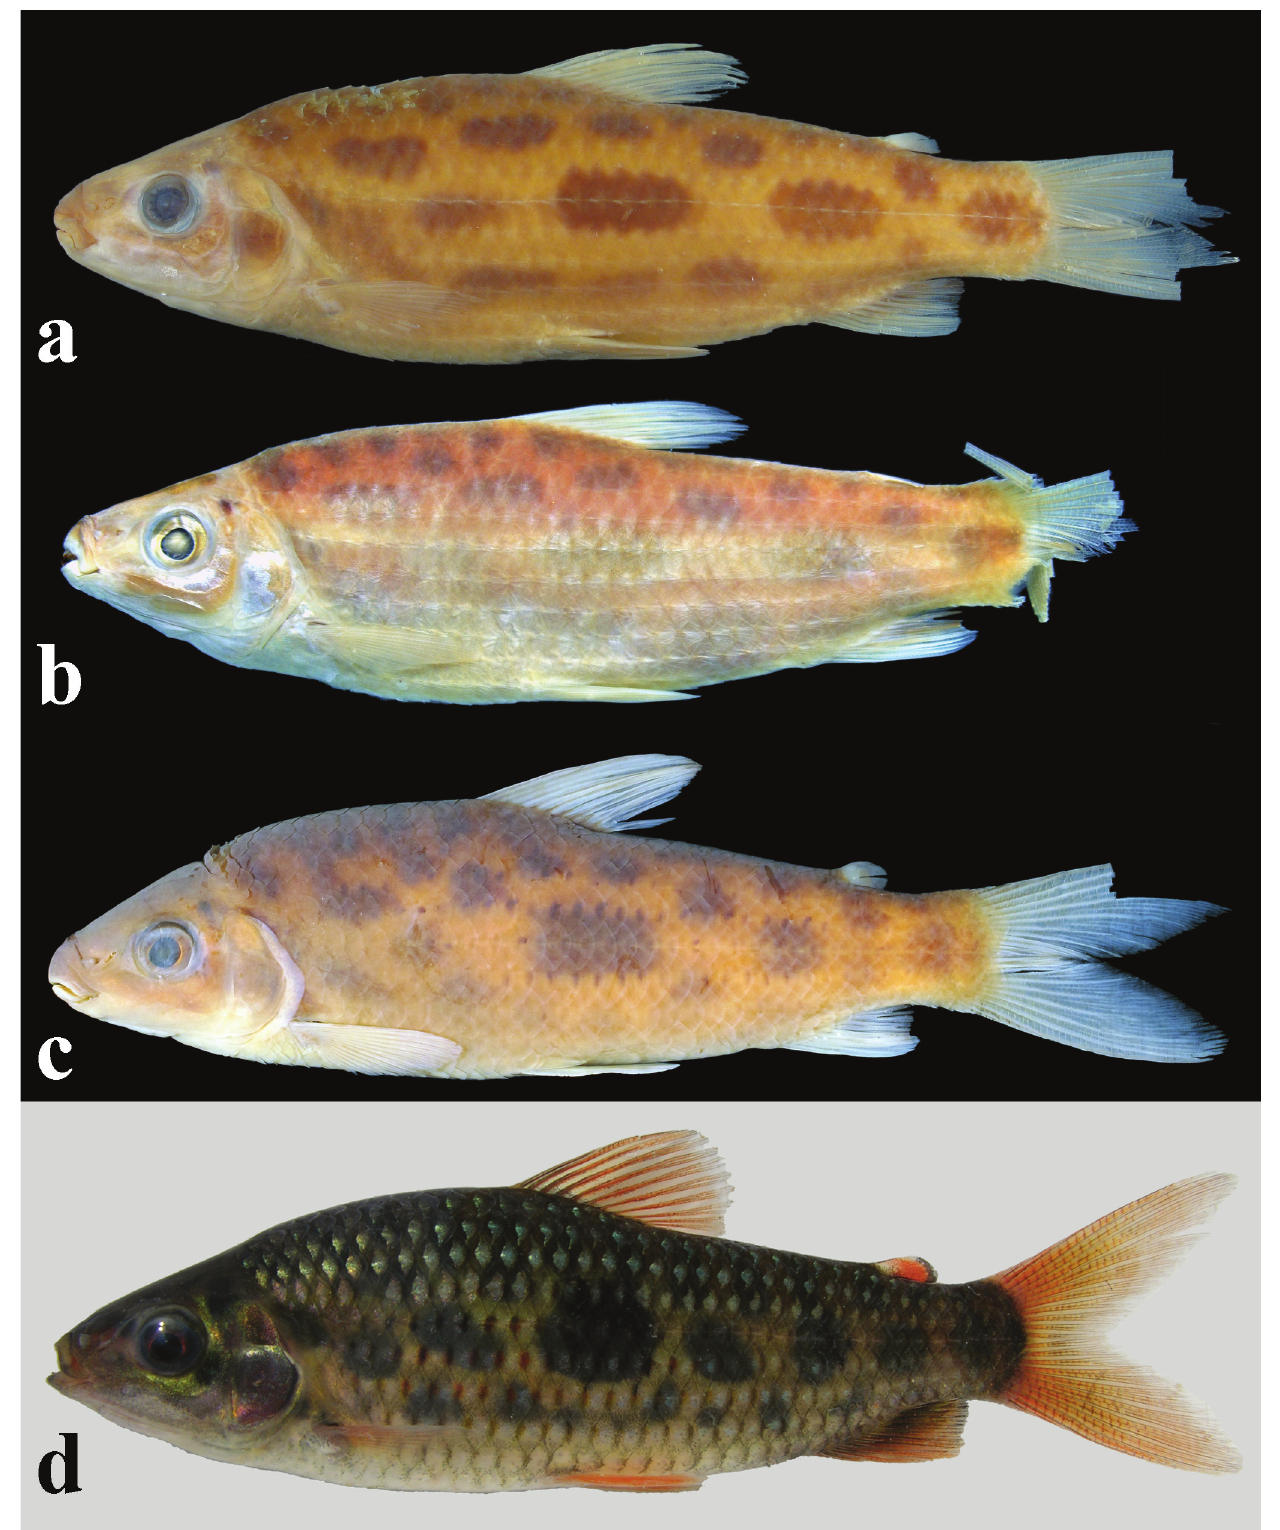
Fig. 4. Leporinus granti : ( a ) holotype, FMNH 53383, 110.5 mm SL, Maripicru creek, a tributary of Ireng River, approximately 4°16’S 59°43’W, Potaro-Siparuni, Guyana; ( b ) BMNH 1864.1.21.44, paralectotype of Leporinus megalepis , 92.9 mm SL, Essequibo River, Ehrhardt; ( c ) MZUSP 14448, 109.7 mm SL, igarapé do Porto, tributary of rio Aripuanã, at Humboldt, Aripuanã, Mato Grosso, Brazil; ( d ) MZUSP 97562, 65.3 mm SL, pool near rio Jamanxim, 7°51’47”S 55°10’47”W, Novo Progresso, Pará, Brazil. Photo d by Mark Sabaj